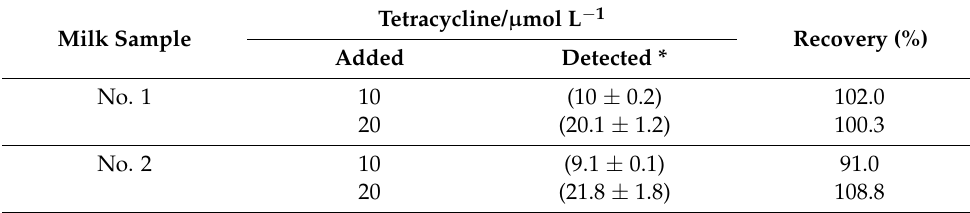
Table 4. Determination of TC in milk